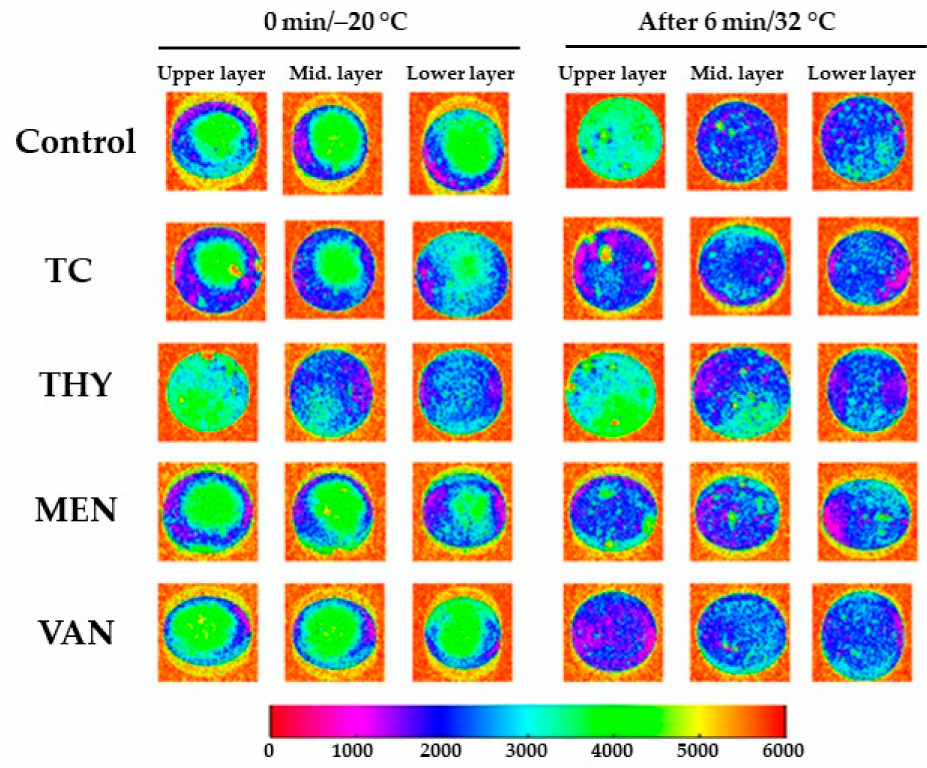
Figure 2. MRI images of TC, THY, MEN, or VAN egg yolk ice creams at 0 min/ − 20 ◦ C and after 6 min/32 ◦